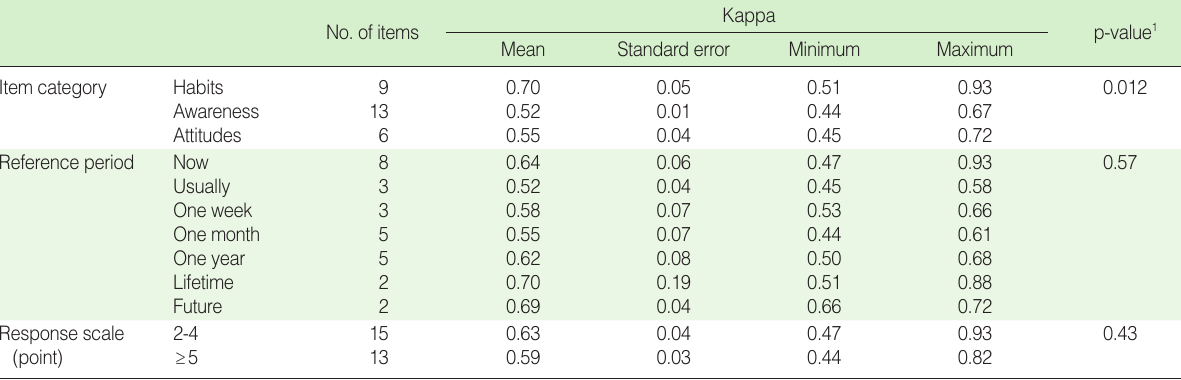
Table 2. Reliability of items by category, reference period, and response